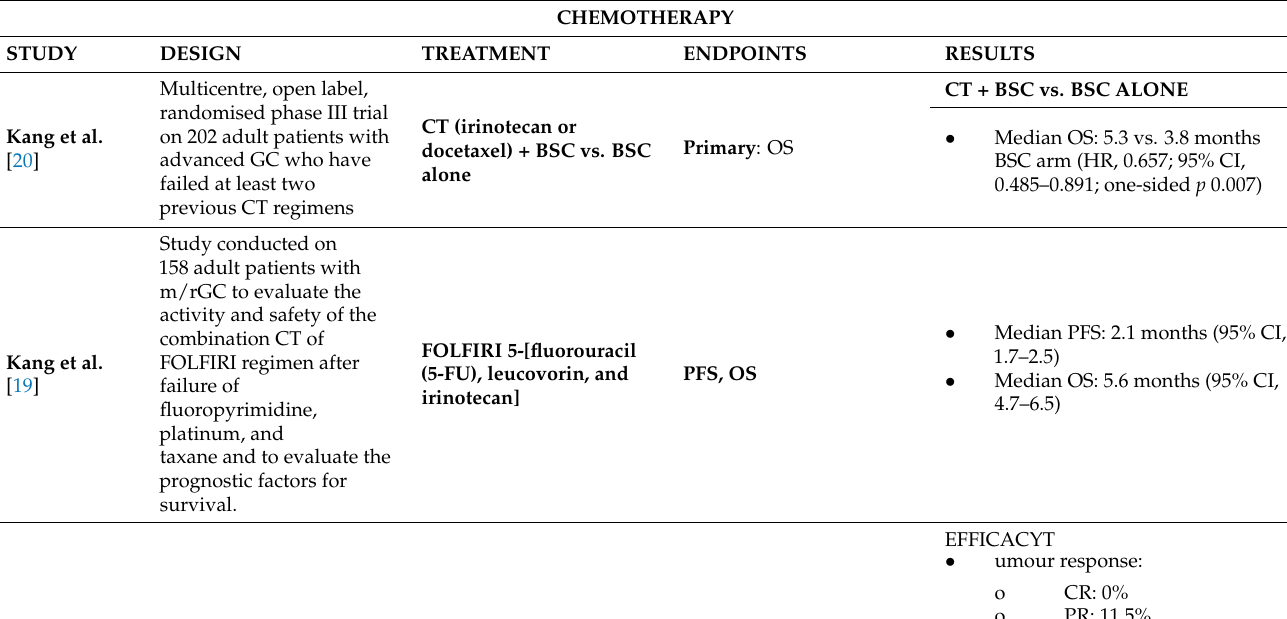
Table 1. Summary of the main third line treatment studies in advanced/metastatic gastric cancer. ( A ) chemotherapy; ( B ) immunotherapy; ( C ) targeted